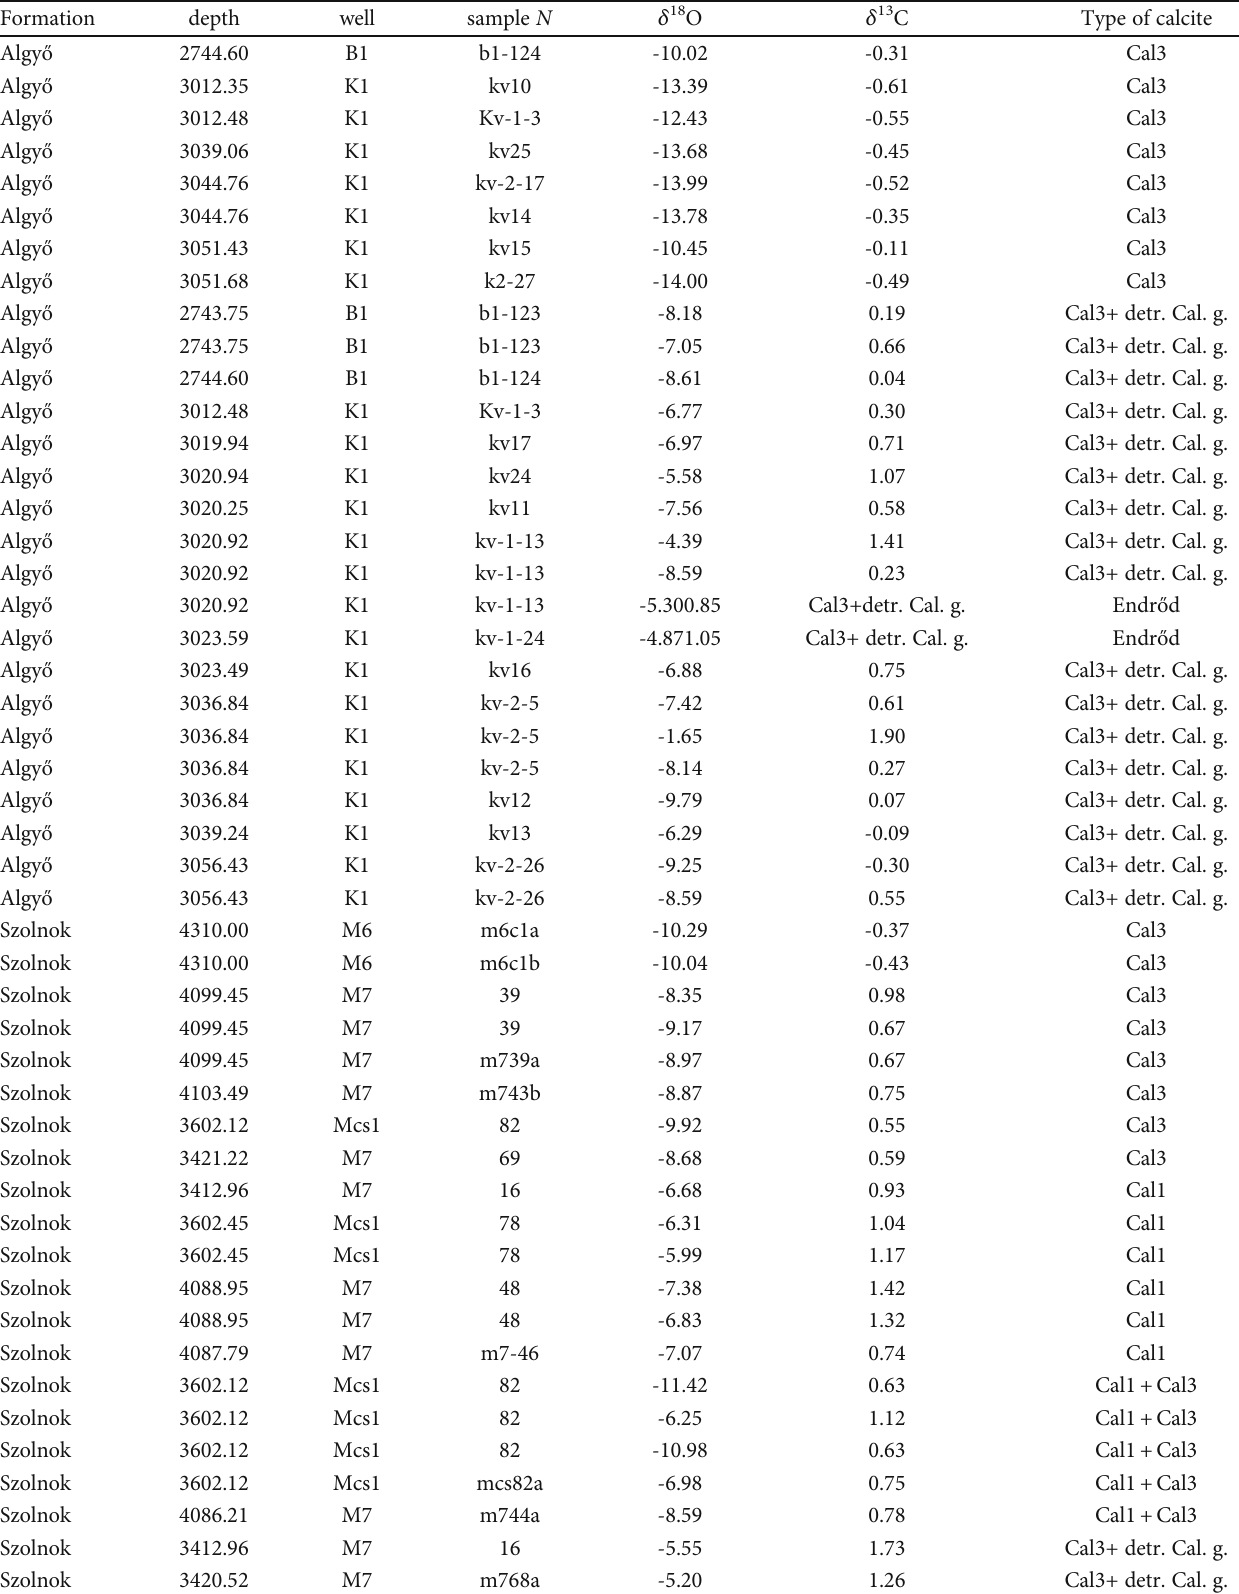
Table 3: Stable oxygen and carbon isotope data of diagenetic and detrital calcite from the studied